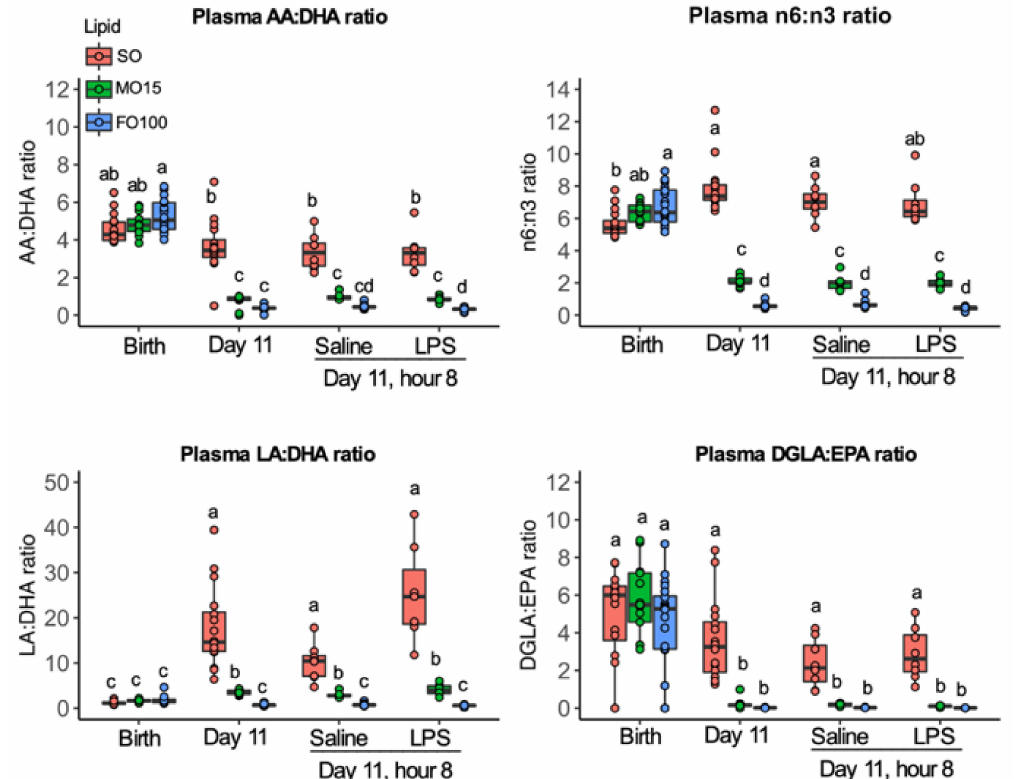
Figure 5. Plasma fatty acid ratios across postnatal age as a function of lipid group. Concentrations of fatty acids were determined by GC-MS and are presented as mol% in the form of boxplots with dots. Data show median and IQR. At day 11, pigs in each lipid group received either LPS or Saline, and fatty acid levels were measured at 8 h at the end of the continuous infusion. Labeled points without a common letter represent a statistically significant difference of p < 0.05. AA, arachidonic acid; DGLA, dihomo- γ linolenic acid; EPA, eicosapentaenoic acid; FO100, 100 percent fish oil; LA, linoleic acid; MO15, mixed oil with 15% fish oil; n -3, omega-3, n -6, omega-6; SO, 100% soybean